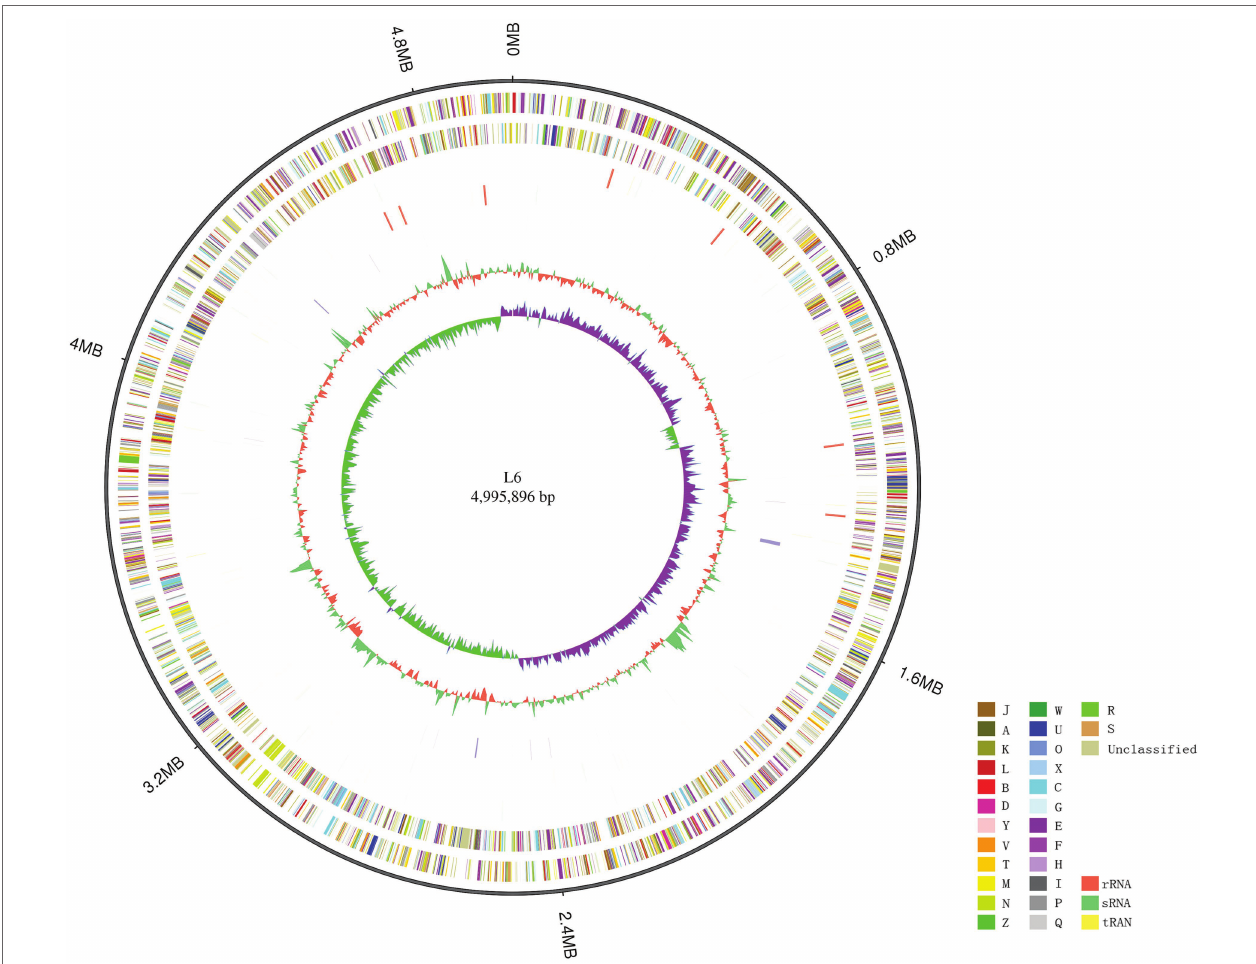
FIGURE 1 | Circular representation of the Pectobacterium aroidearum L6 genome. From outer to inner: first circle is genome size; second and third circles are forward and reverse strand gene, respectively, colored according to cluster of COG classification (A, RNA processing and modification; B, chromatin structure and dynamics; C, energy production and conversion; D, cell cycle control, cell division, and chromosome partitioning; E, amino acid transport and metabolism; F, nucleotide transport and metabolism; G, carbohydrate transport and metabolism; H, coenzyme transport and metabolism; I, lipid transport and metabolism; J, translation, ribosomal structure, and biogenesis; K, transcription; L, replication, recombination, and repair; M, cell wall/membrane/envelope biogenesis; N, cell motility; O, posttranslational modification, protein turnover, and chaperones; P, inorganic ion transport and metabolism; Q, secondary metabolites biosynthesis, transport, and catabolism; R, general function prediction only; S, function unknown; T, signal transduction mechanisms; U, intracellular trafficking, secretion, and vesicular transport; V, defense mechanisms; W, extracellular structures; X, mobilome: prophages, transposons; Y, nuclear structure; Z, cytoskeleton); fourth and fifth circles are ncRNA (yellow indicates tRNA, orange indicates rRNA, and green indicates sRNA) and repeat, respectively; seventh circle is GC content (green indicates greater than average value, and orange indicates less than average value); and eighth circle is GC-SKEW (GC-SKEW = (G − C)/(G + C), purple indicates >0, and green indicates